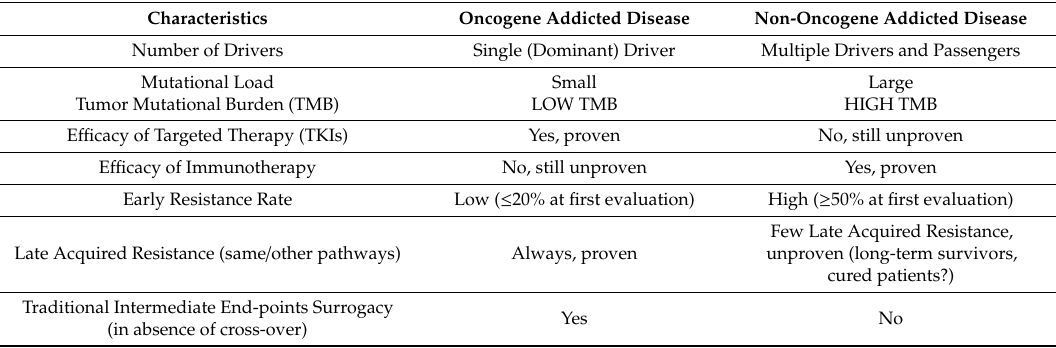
Table 3. Di ff erences between oncogene-addicted and non-oncogene addicted